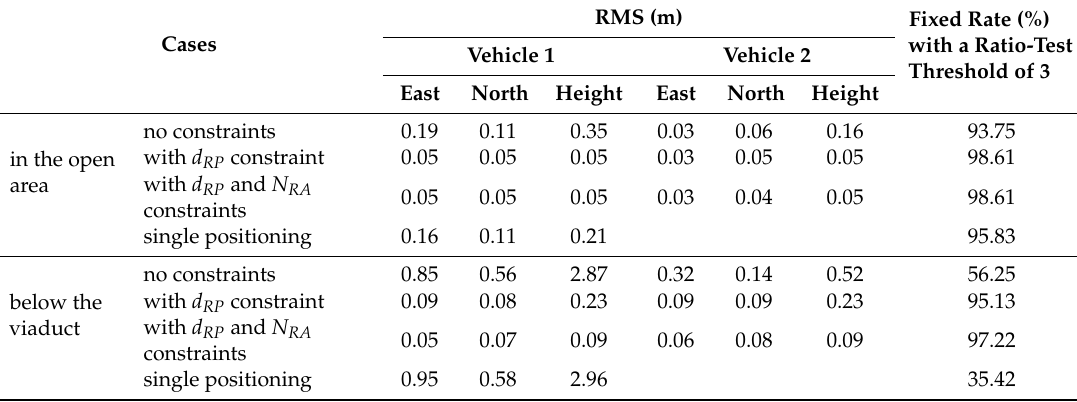
Figure 12. Positioning errors in east, north and height directions of the vehicle 1 in the absolute positioning for our joint RTK algorithm and single point positioning. Table 3. Absolute positioning precision and fixed rate of all cases.